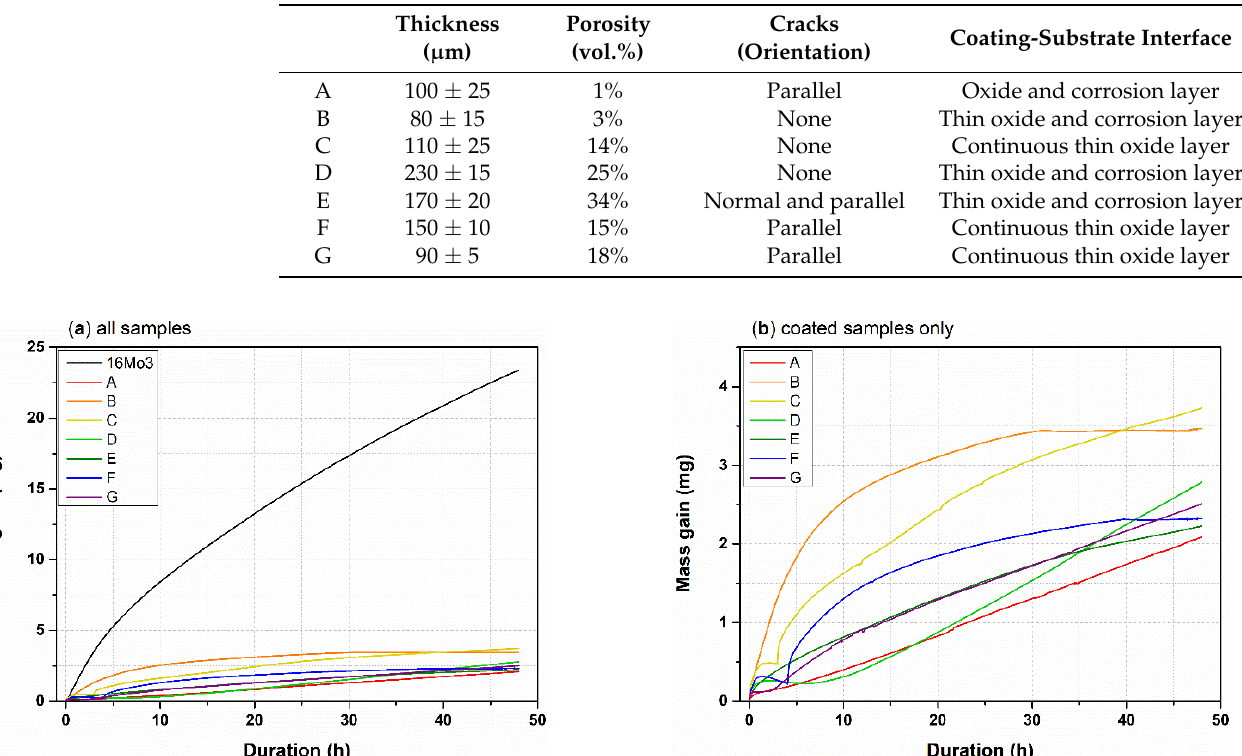
Table 2. Summary of the main microstructural features of the enamel coatings on low-alloyed 16Mo3 boiler steel (the vol.% of porosity is based on image analyses of the cross-sections and should be considered as comparative values).